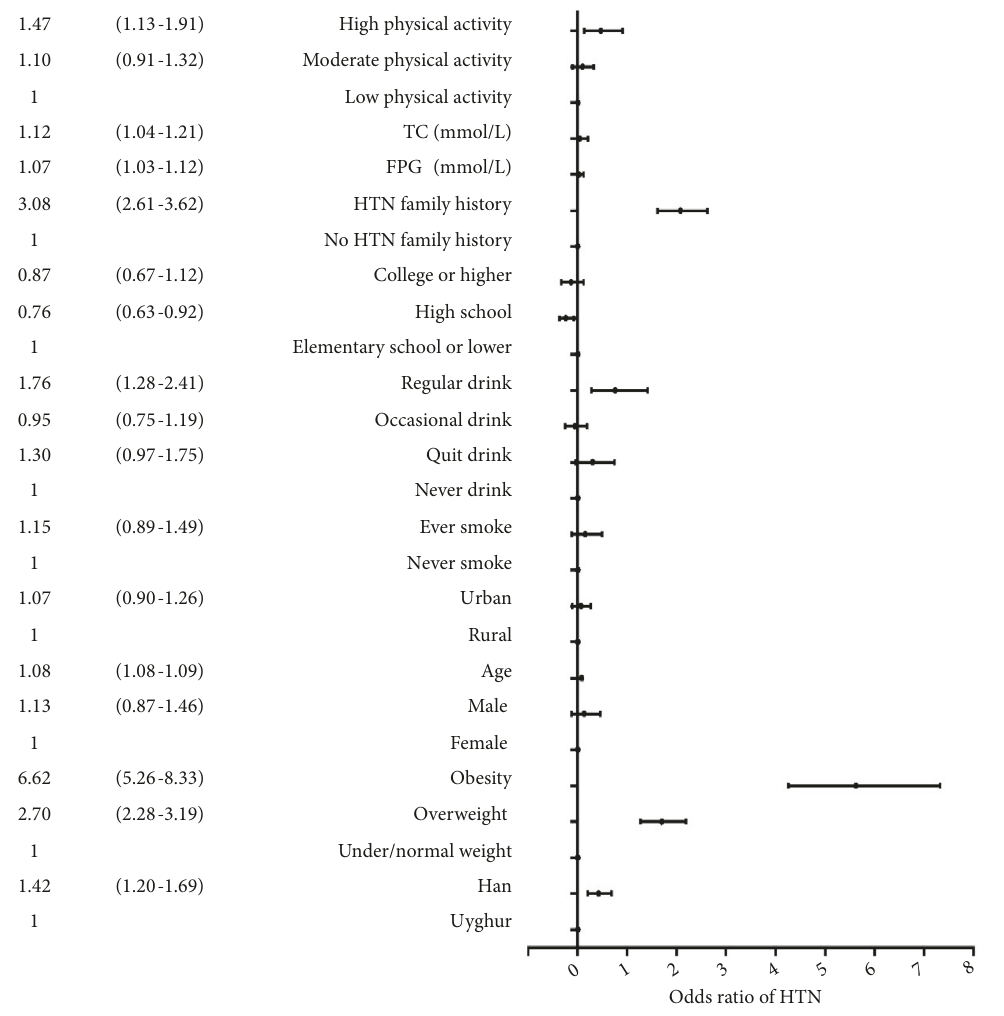
Figure 2: Associated factors of hypertension in participants. HTN: